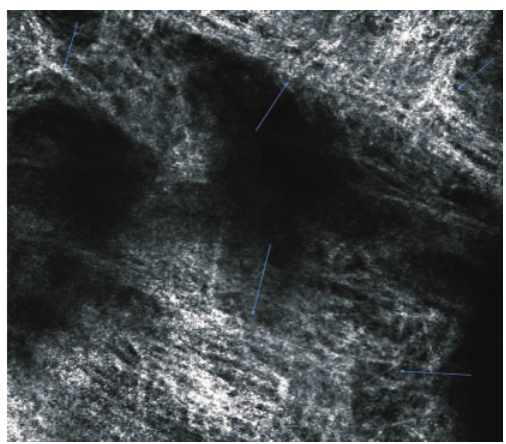
Figure 10: Reflectance confocal microscopy image at the lamina propia showing apperance of collagen fibers and bundles. Blue arrows: collagen fibers.